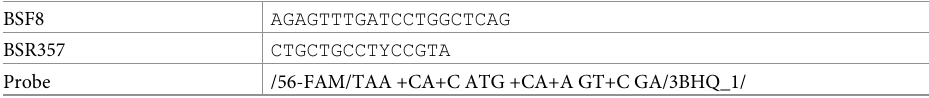
Table 1. Primer and probe